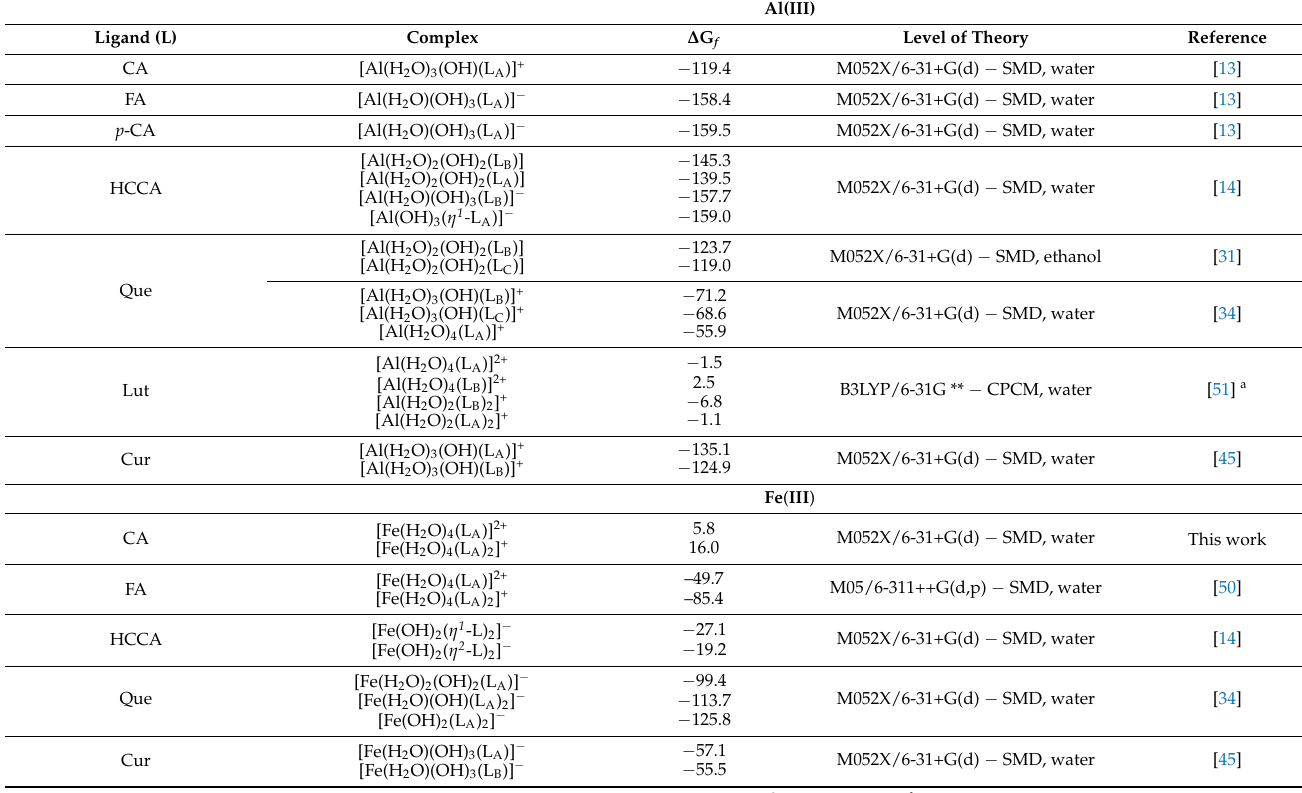
Figure 1. Bathochromic shift of the first absorption band upon complexation with Al(III) and Fe(III) metal ions of the different NAMs. Data were taken from references collected in Table 2, with the exception of: Fe(III)-CA spectrum recorded in aqueous solution at pH = 9 [54] and here calculated; Fe(III)-FA spectrum here calculated; Lut-Al(III) in MeOH-water (1/2 v / v ) [55]; Lut-Fe(III) in EtOH [56]. Table 2. Free energy formation ( ∆ G f ) of the complexes formed between the selected natural antioxidants and Al(III) or Fe(III), calculated according to Equation